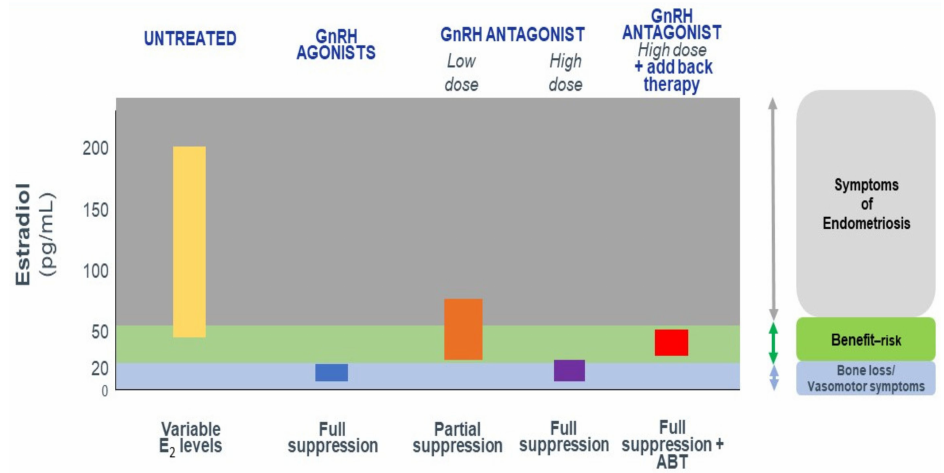
Figure 2. Expected estradiol (E2) levels during the menstrual cycle, under GnRH agonist and under GnRH antagonist therapy without and with add-back therapy